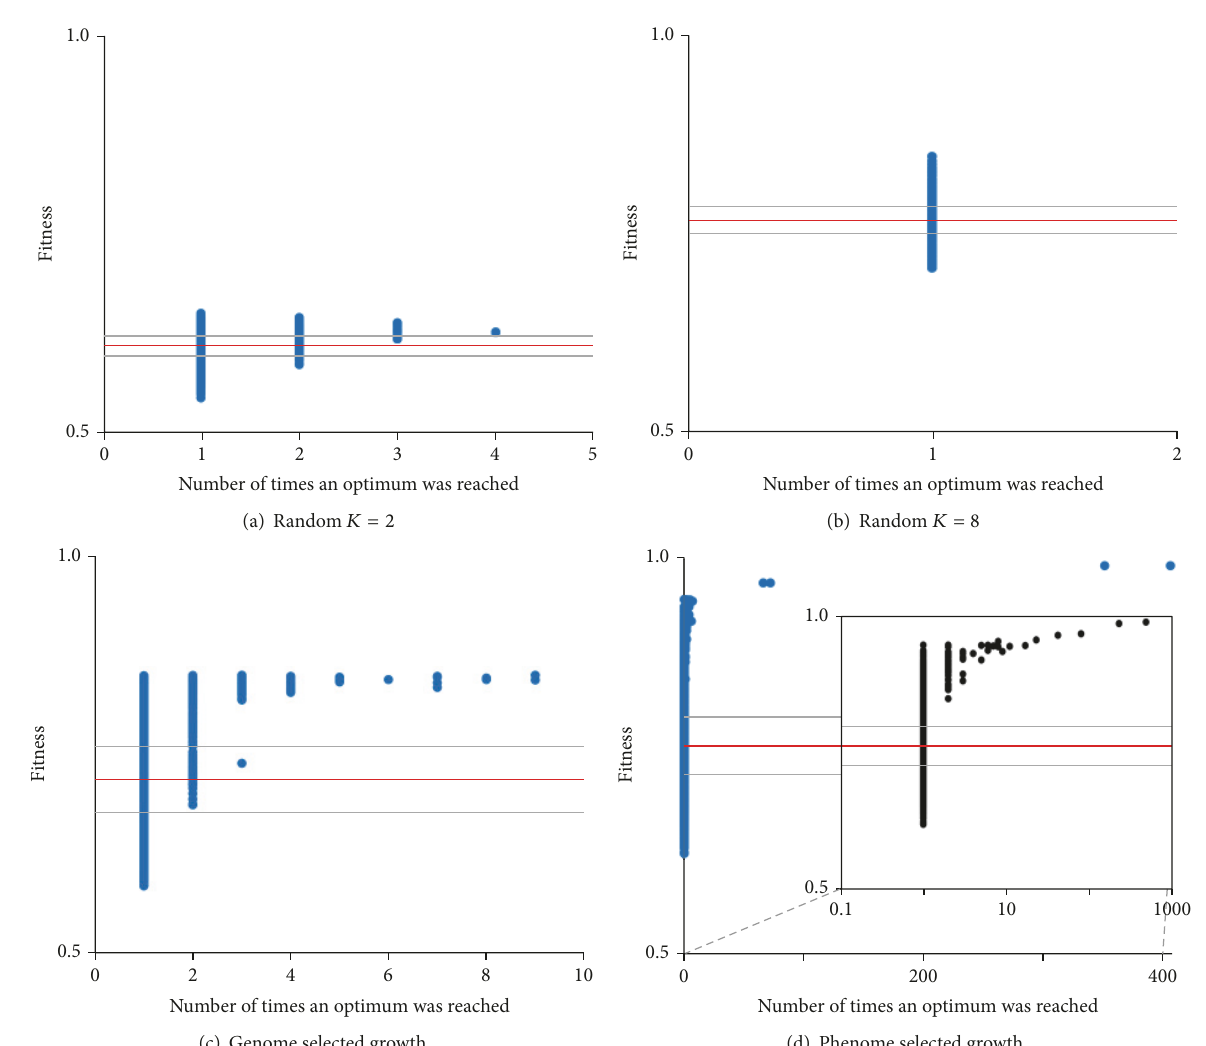
Figure 3: Comparison of basins: the accessibility of local optima discovered by 100,000 independent adaptive walks on four types of 𝑁 = 96 landscape, shown in blue. (a) The 𝐾 = 2 random landscape, 99249 unique optima. (b) The 𝐾 = 8 random landscape, 100,000 unique optima. (c) The Genome selected landscape, 99381 unique optima. (d) Phenome selected landscape, 98977 unique optima. The log scale panel shows the same phenome selected landscape data in black. Red horizontal lines show mean and grey horizontal lines show one standard deviation from the